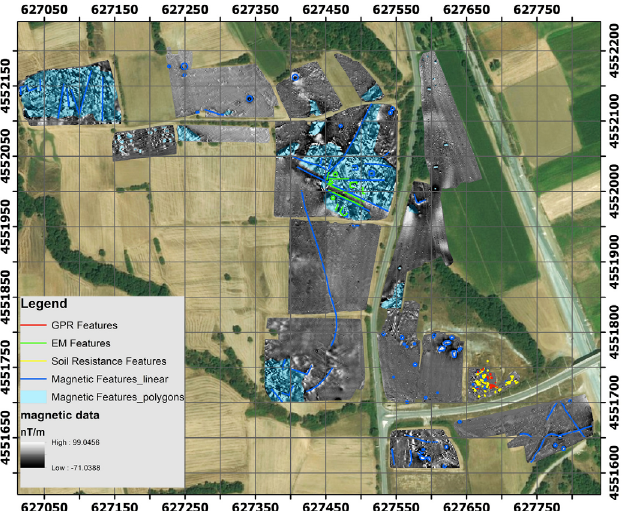
Figure 3. Geophysical survey surrounding the archaeological site at Idomeni (EGSA 1987, Greek national